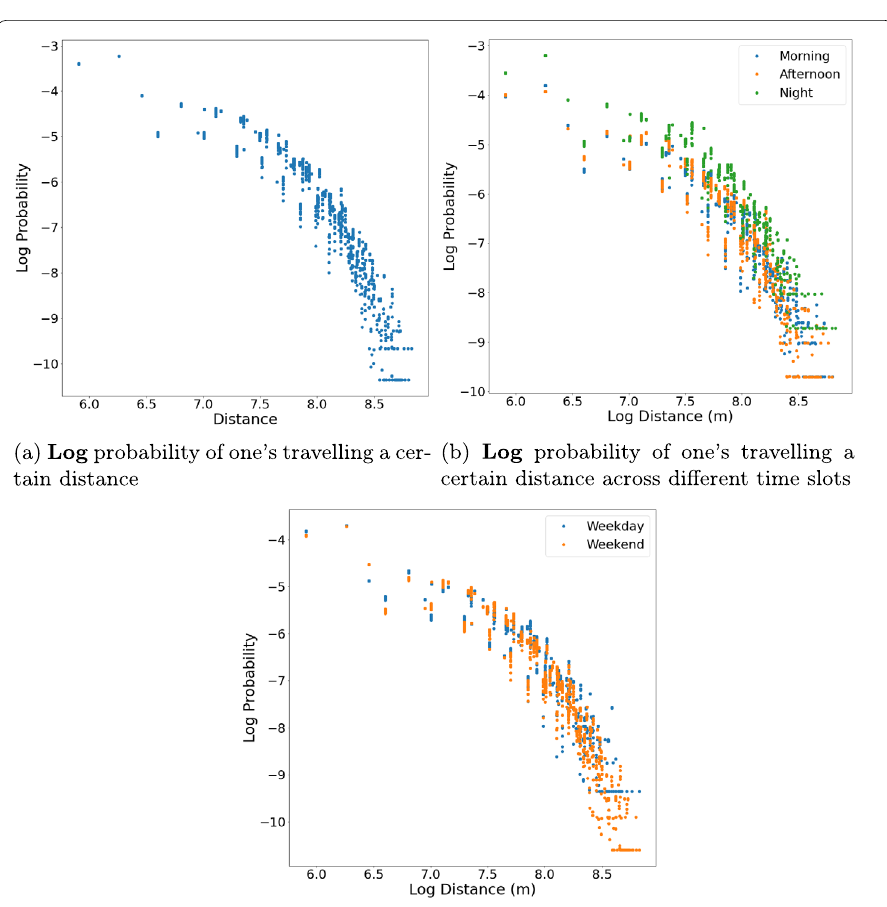
Figure 6 Log probability of one’s